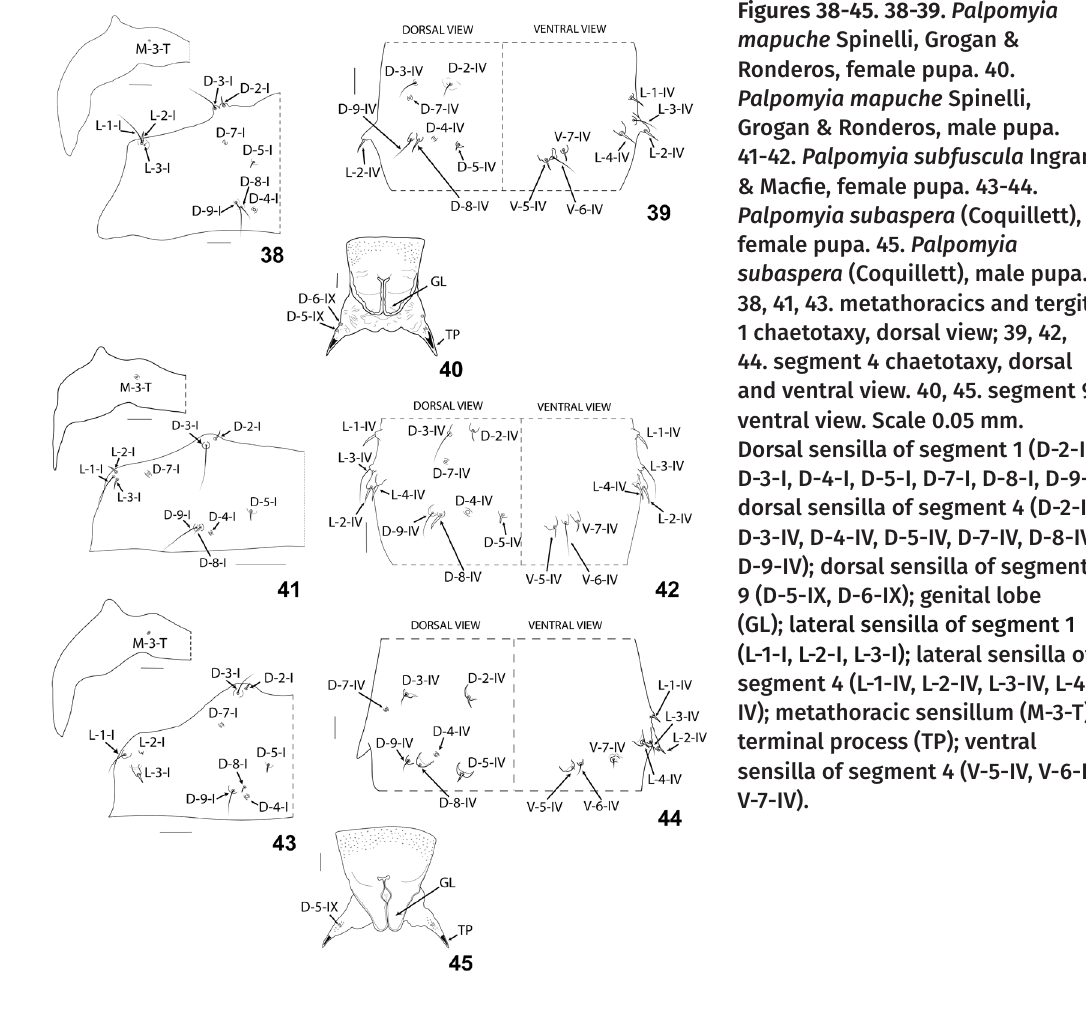
(Fig. 36): AL-1-T short, curved, stout seta; dorsals (Fig. 37): D-1-T, D-2-T, D-4-T, D-5-T long, thin setae, D-3-T campaniform sensillum, all on small rounded tubercle; metathoracic (Fig. 43): M-3-T campaniform sensillum, near anterior margin of metathorax. Abdomen: segments with anterior and posterior bands bearing small spicules; with simple setae; segment 9 (Figs. 22–23) approximately 1.6 longer than broad, length 0.31 mm, width 0.20 mm; dorsal and ventral surface bearing band of pointed spicules on anterior margin; dorsal and ventral surface smooth; ventral surface with one small, ventral surface with one small, star-shaped mark located on